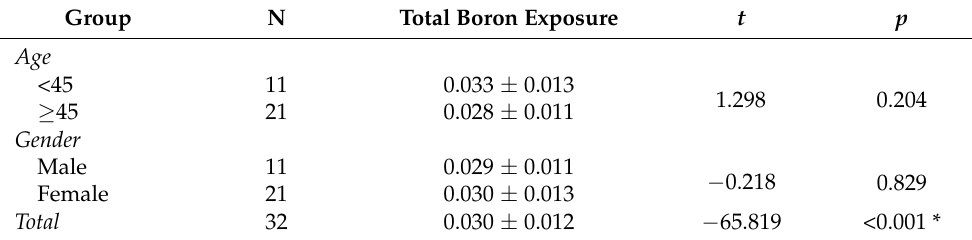
Table 6. Total boron exposure in different populations (mg/kg bw per